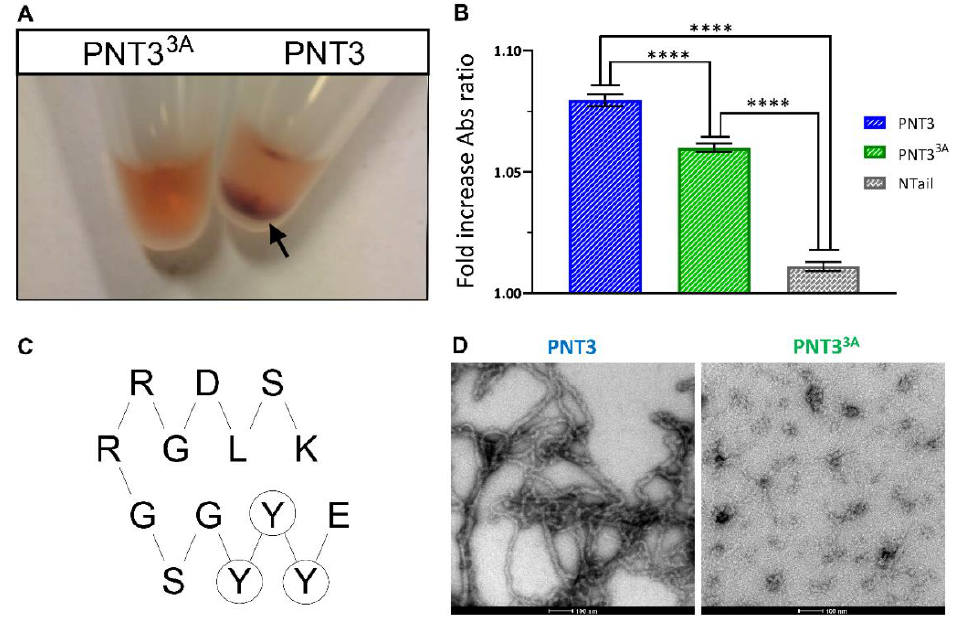
Figure 4. ( A ) CR binding by purified PNT3 and PNT3 3A . Proteins were incubated at 40 µ M in the presence of 5 µ M CR for 3 weeks at RT in 50 mM sodium phosphate pH 6.5, 5 mM EDTA. The arrow points to the dense phase on the bottom of the tube that binds the CR observed for PNT3 but not for PNT3 3A . ( B ) Fold increase in the ratio between the absorbance at 515 and the absorbance at 497 nm, with respect to a sample containing CR alone (at 5 µ M), of a PNT3, or PNT3 3A , or NTail (control) sample at 20 µ M after 1 h of incubation at 37 ◦ C. Note that PNT3 and PNT3 3A were incubated for 1 week at 37 ◦ C before the addition of CR. The error bar corresponds to the standard deviation, with n = 9 for PNT3 and PNT3 3A , and n = 5 for Ntail. The four asterisks denote a statistically significant difference ( p < 0.0001) (one-way ANOVA test). ( C ) Output was provided by ArchCandy [65] when submitting the amino acid sequence of PNT3. The three contiguous tyrosines within the amyloidogenic EYYY motif, which were targeted for mutagenesis, are circled. ( D ) TEM micrographs of a PNT3 or PNT3 3A sample at 200 µ M after a 56-h incubation at 37 ◦ C.